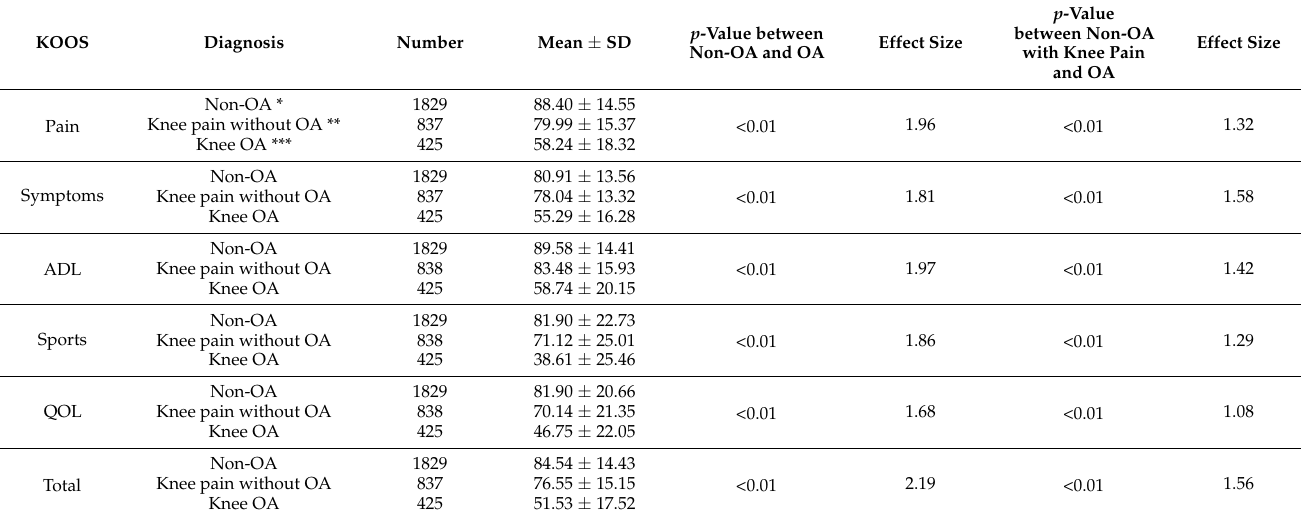
Table 5. Comparison between non-OA and knee OA participants and between non-OA with knee pain and knee OA participants based on KOOS